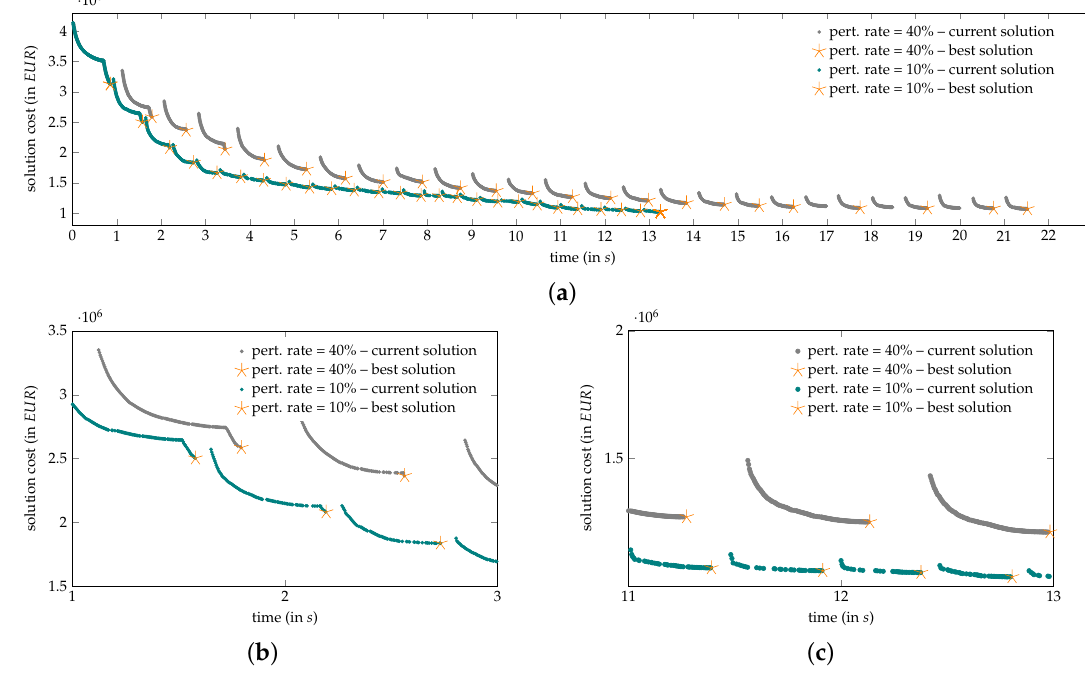
Figure 12. Effect of different perturbation